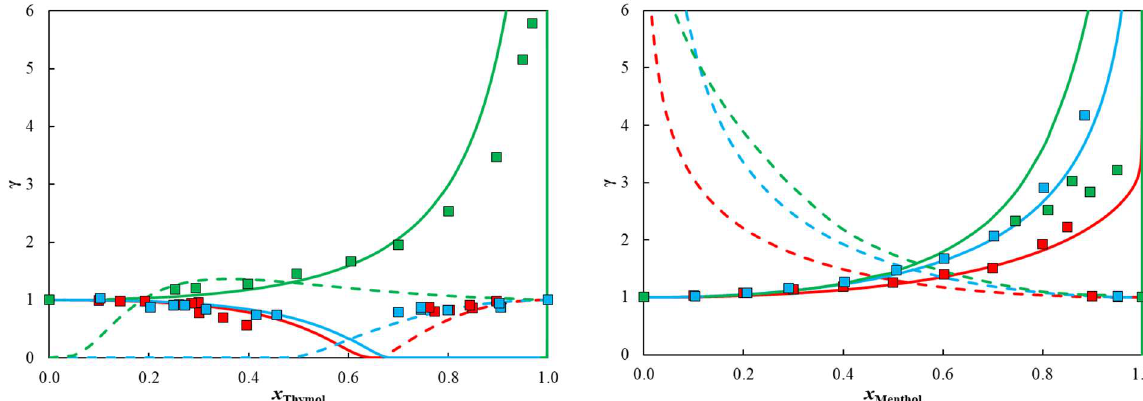
Figure 4. Non-isothermal activity coefficients predicted by COSMO-RS whilst calculating their solid-liquid equilibrium diagram. Symbols represent experimental activity coefficients obtained through Equation (2). Full lines represent flavone (red), flavanone (blue), or hesperetin (green) and the dashed lines represent the second component (thymol or menthol).